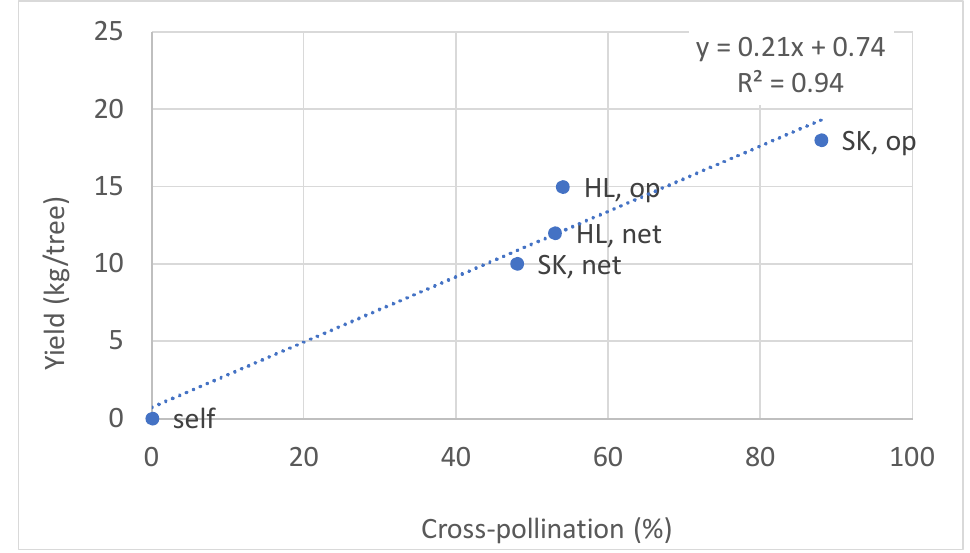
Figure 6. Correlation between the rate of cross-pollinated and final fruit yield. Op—open pollina- tion. Self—self-pollinated under a net. Net—trees covered with nets. Each point is an average of 4 trees (replicates).